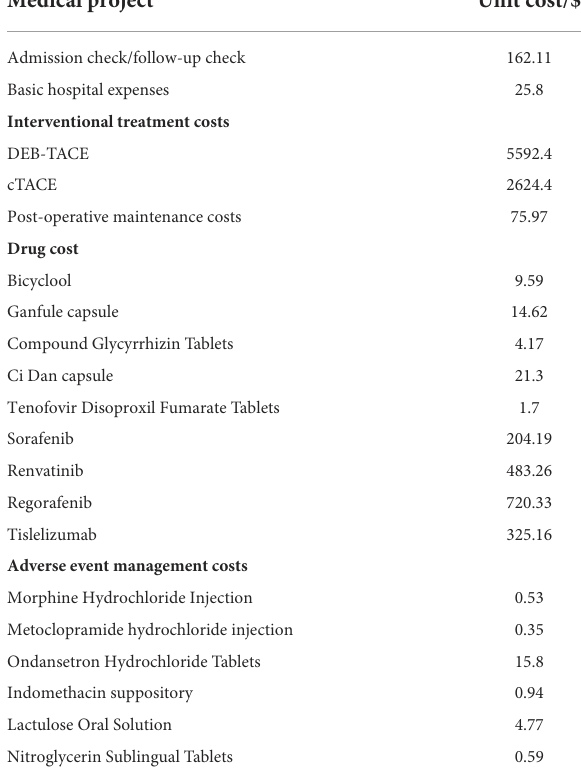
TABLE 3 The main unit